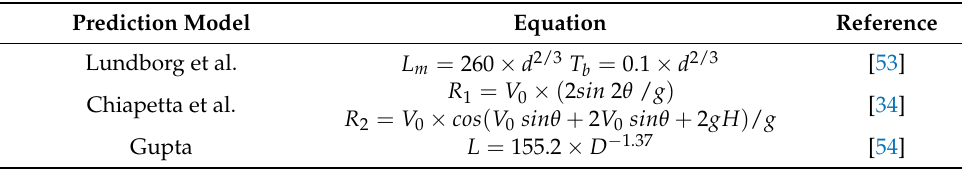
Table 5. Empirical models for predicting the